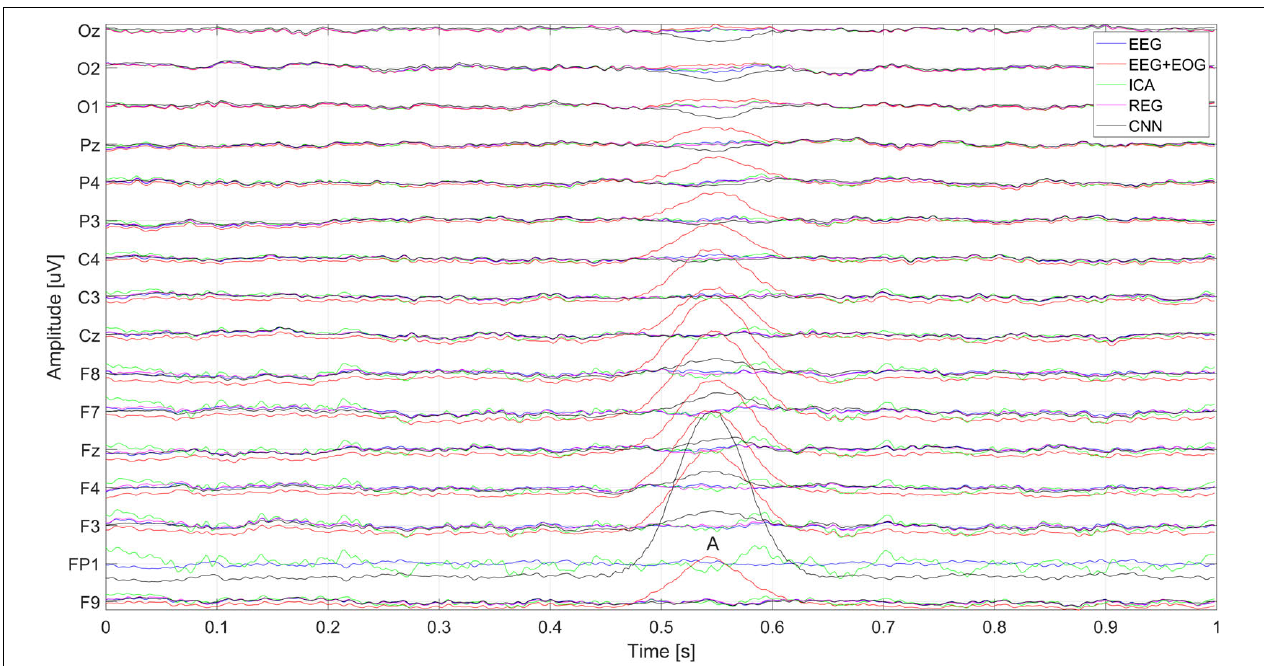
FIGURE 15 | Artificially generated 1-s window of pure EEG, EEG + EOG, and cleaned signal using ICA, regression, CNN methods. The letter A represents the moment the blink artifact